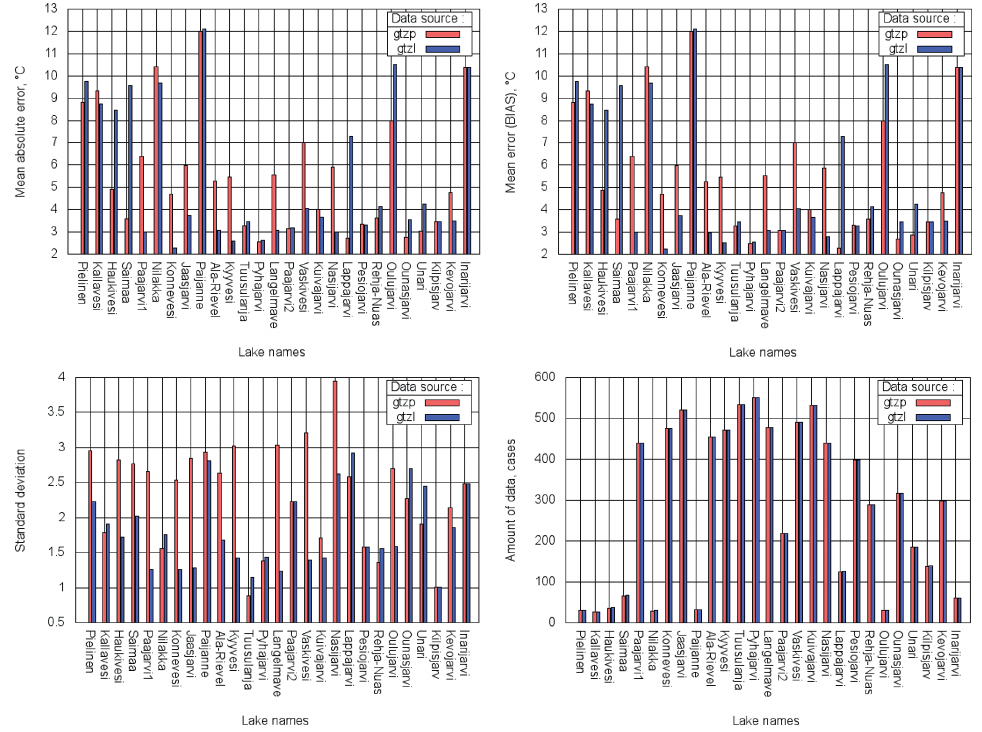
Figure 15. Same as Fig. 14 but calculated over all spring mixing